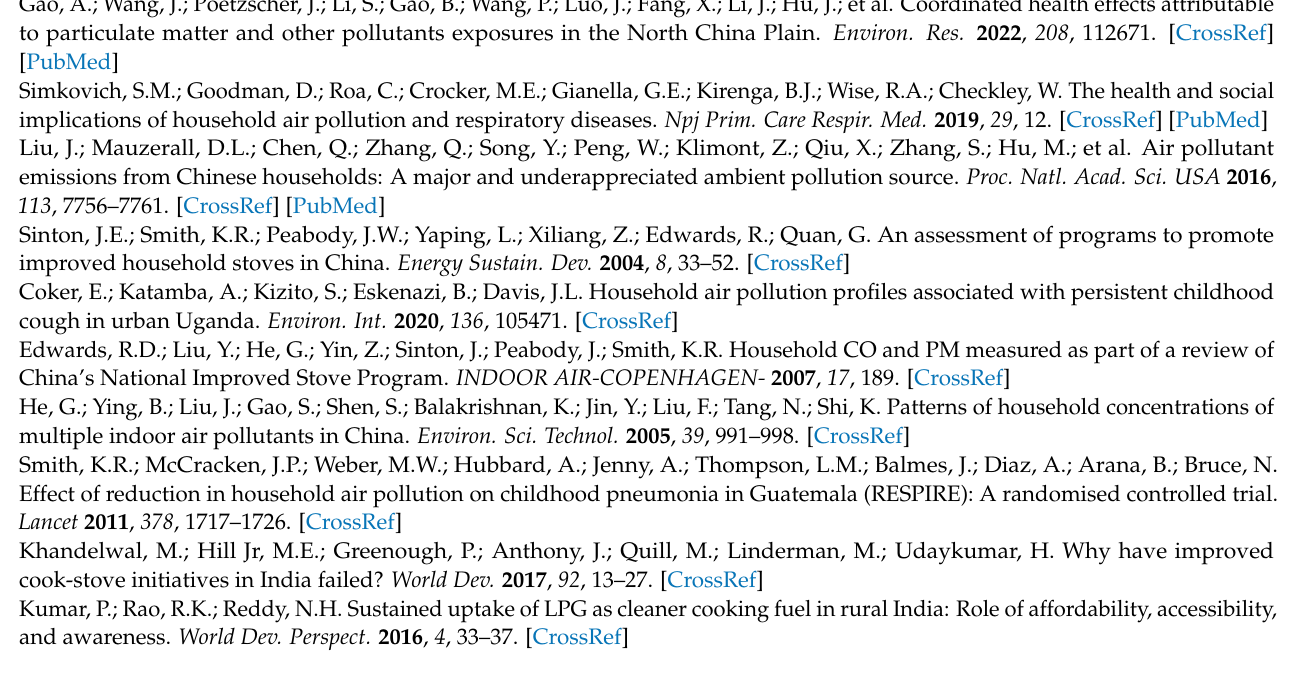
(1); Table S7: Variance inflation factors of Models 1~8; Table S8: Description of willingness to pay; Table S9: The original scores of case and control